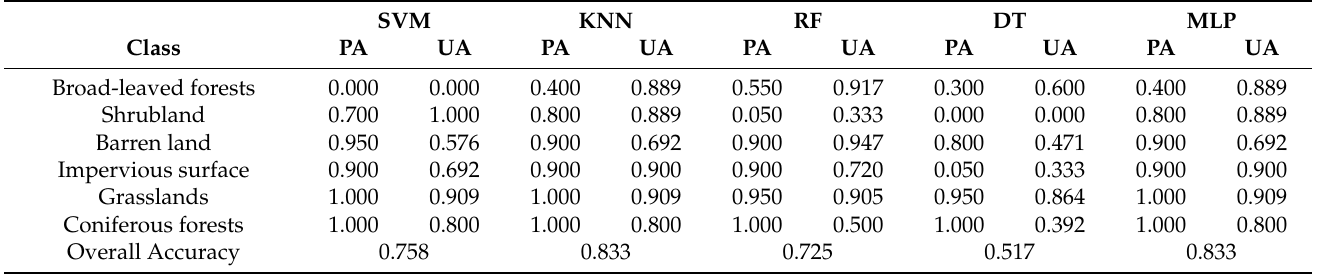
Table 5. Forest land resource information accuracy of five classifiers (SVM, KNN, RF, DT and MLP) based on Mul-vegetation.